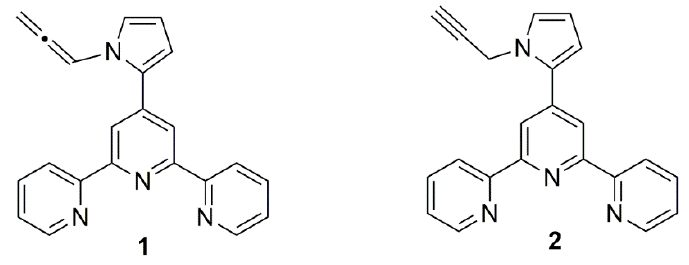
Figure 1. Structures of terpyridine compounds ( 1 ) and ( 2 ).